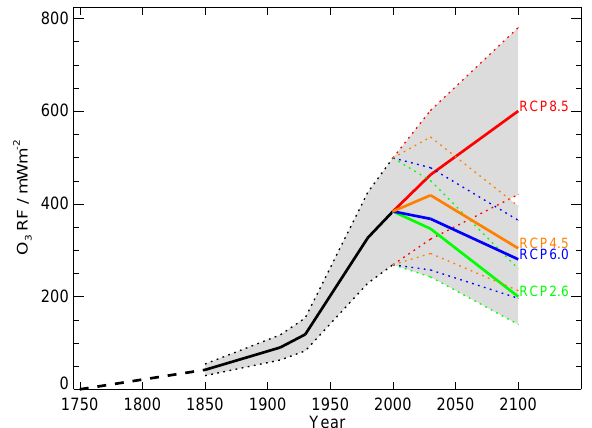
Fig. 5. Evolution of tropospheric ozone RF (mW m − 2 ) , 1750–2100. For 1750–1850, we show the estimate of Skeie et al. (2011). For 1850–2000 (black line), we show MMM values for all available AC- CMIP timeslices. For 2000–2100, the four RCP scenarios are shown in different colours, using values at 2030 and 2100 only. Estimated uncertainties of ± 30% on all values are indicated by the grey shad- ing, bounded by dotted coloured lines. Values have been scaled to the average of the MASKZMT and MASK150 tropopauses, and the three radiation schemes used (Edwards-Slingo, Oslo, and NCAR).